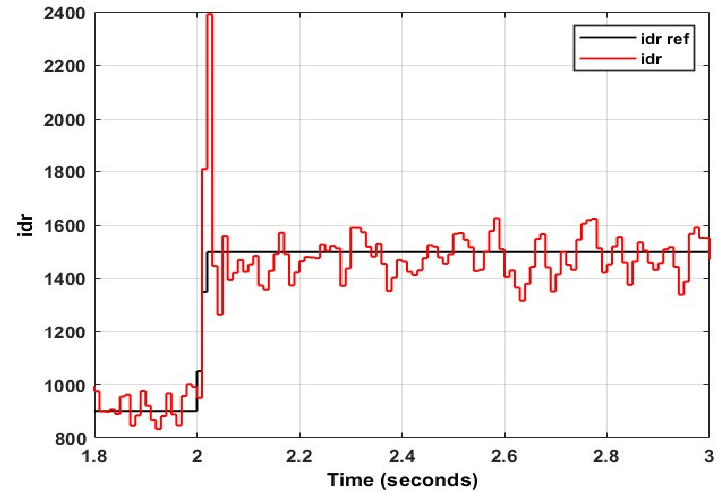
Figure 23. Rotor direct axis current ripple using PI at 70% dip.